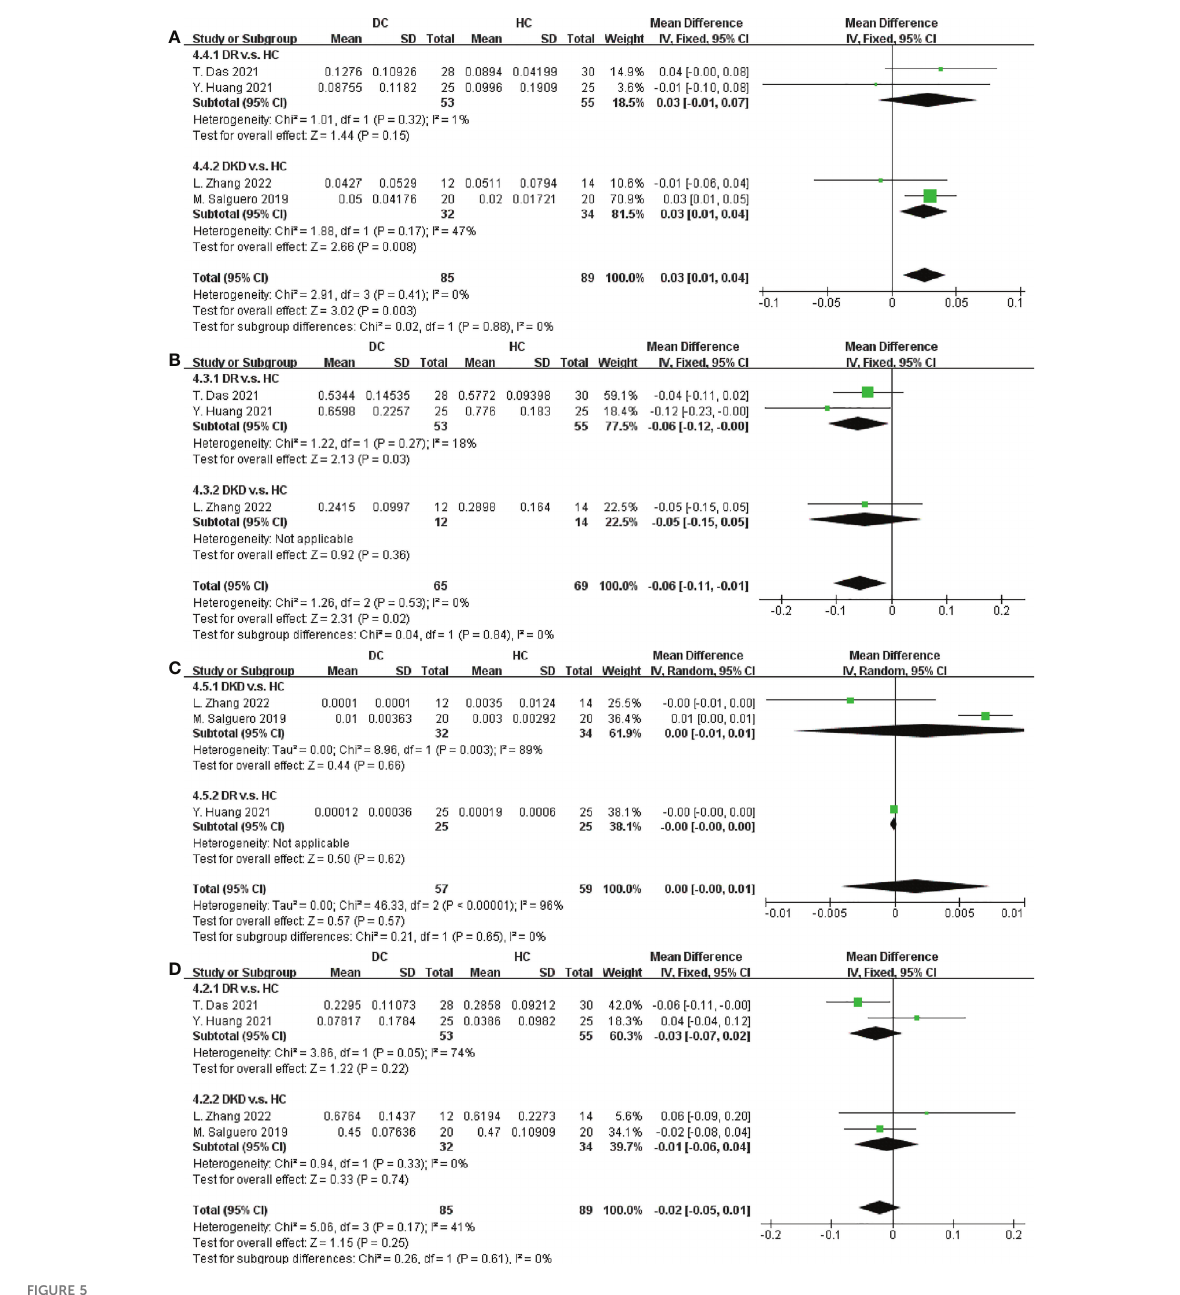
FIGURE 5 Forest plots of microbiota at the phylum level in DC v.s. HC. (A) Proteobacteria; (B) Firmicutes; (C) Fusobacteria; (D)